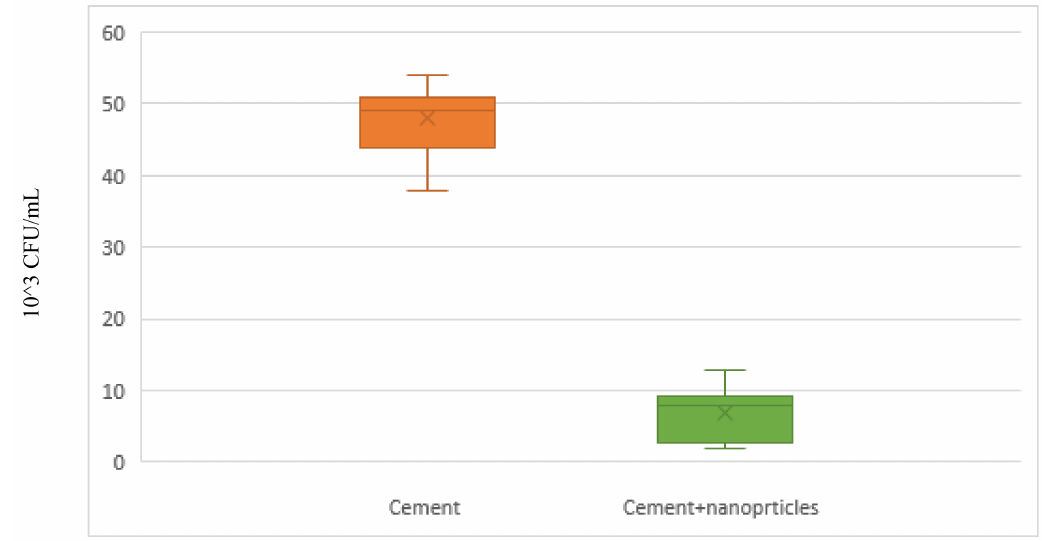
Figure 3. Neobond incorporating 1% QPEI reduces bacterial viable counts of S. mutans adjacent to bonded